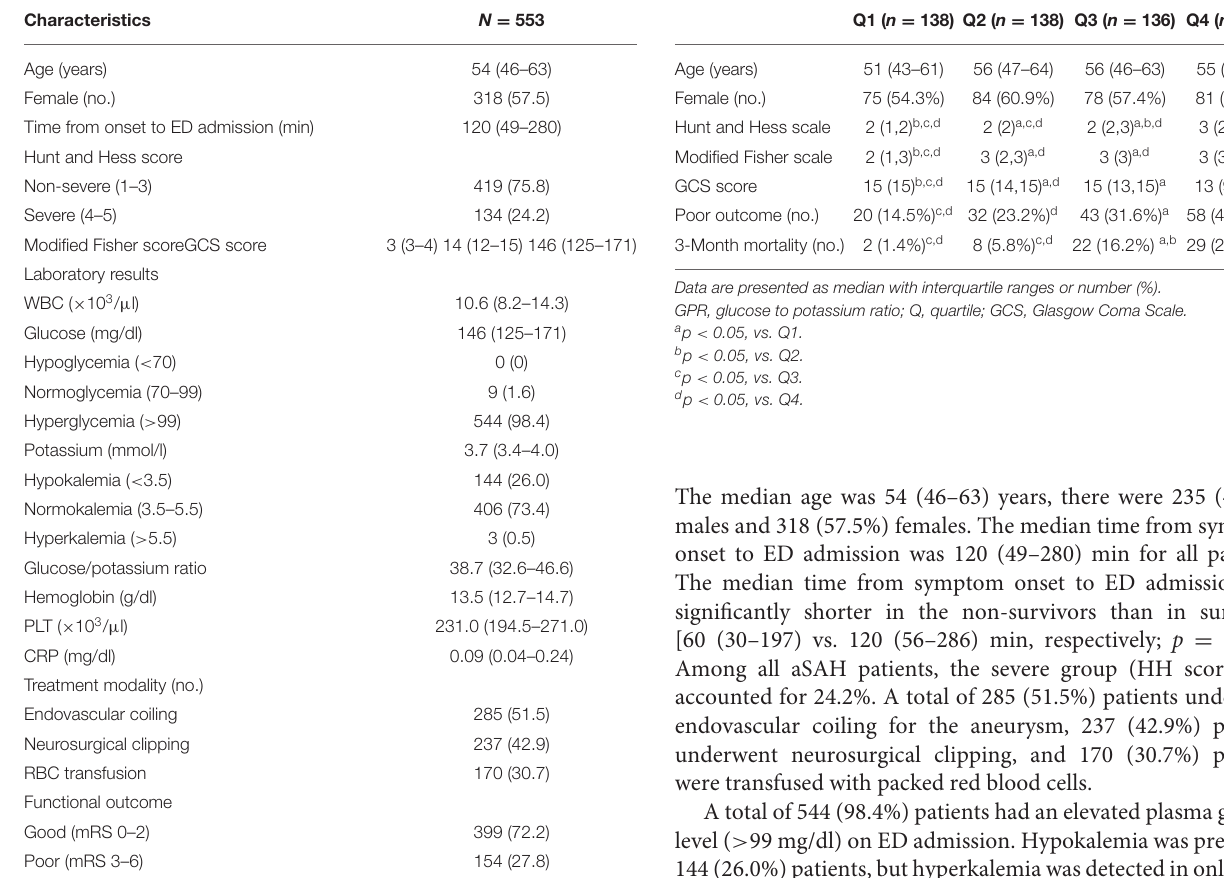
TABLE 2 | Clinical features according to GPR